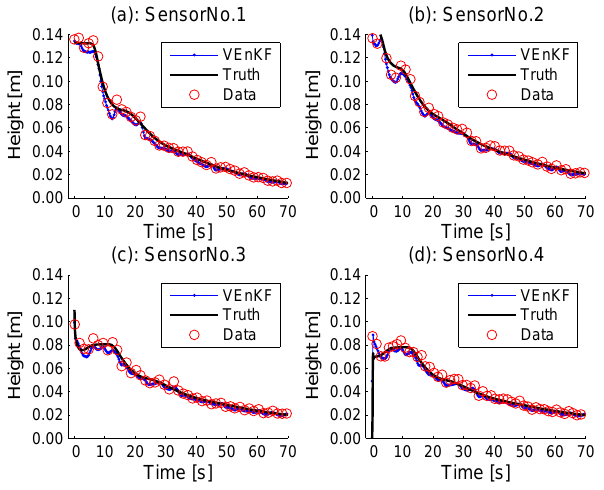
Fig. 5. Experiment 1: Comparison of VEnKF estimates, true water depth and data of the dam break experiment for the last four sensors.